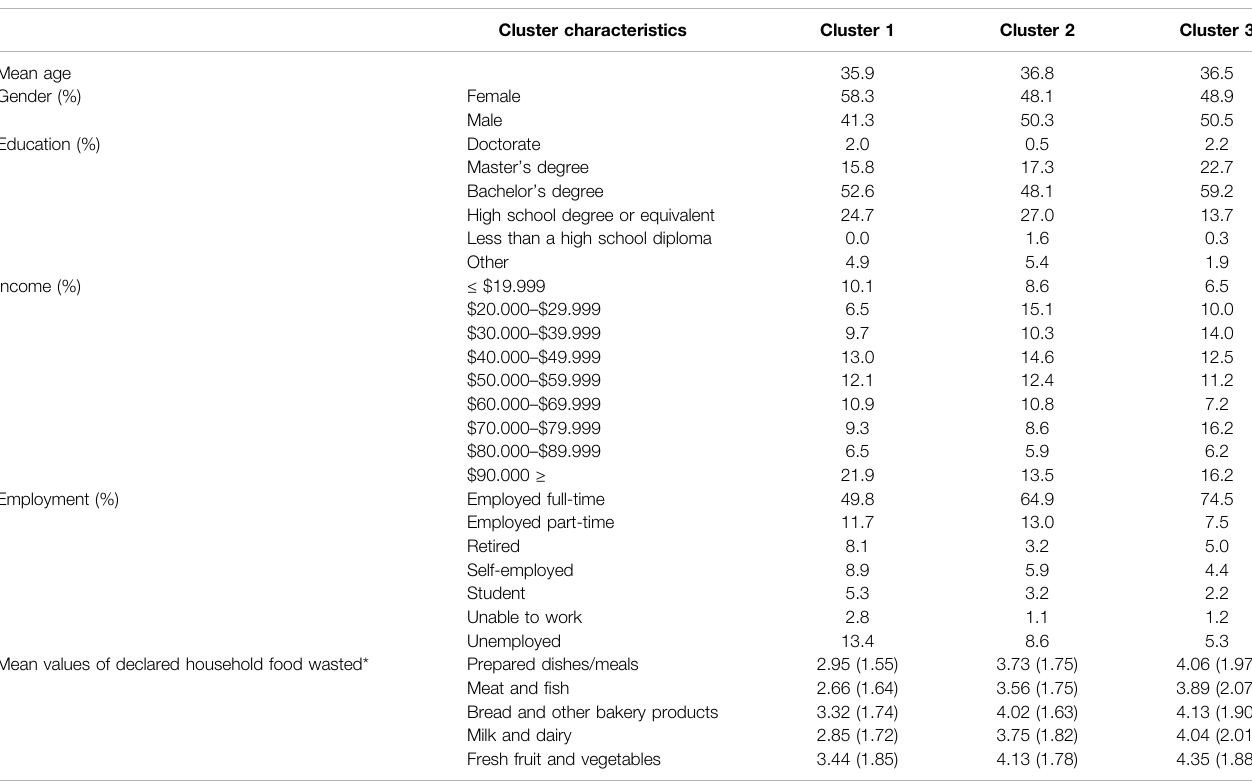
TABLE 4 | Cluster